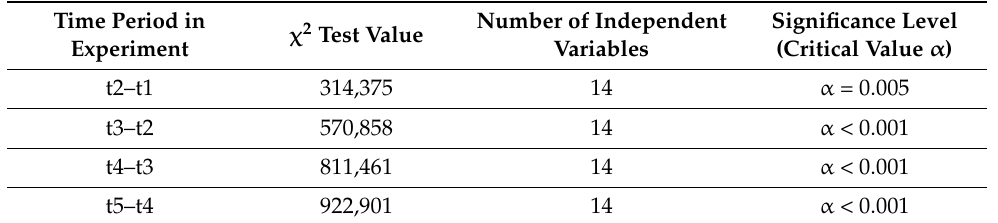
Table 3. Calculations of χ 2 test for sequence of period of